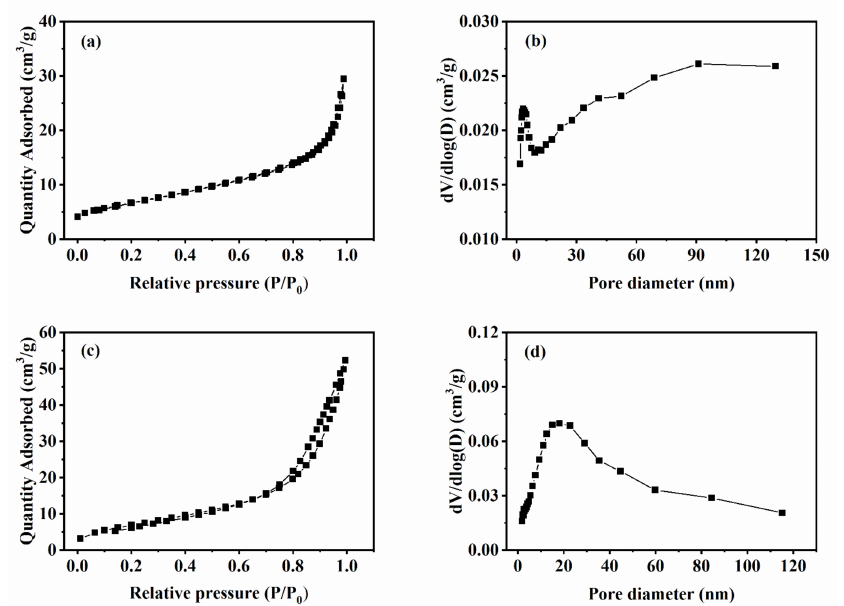
Figure 8. N 2 adsorption–desorption isotherm and pore size distribution of the formed WO 3 with different shapes. ( a , b ) WO 3 nanobundles, ( c , d ) WO 3